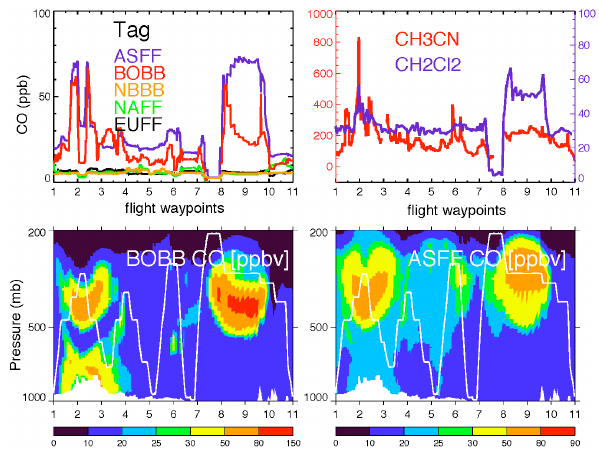
Fig. 6. Top left: the five tagged CO mixing ratios during the ARC- TAS flight 21 on 8 July from Cold Lake, Canada, terminating in with the white line representing the flight track. Thule, Greenland. Top right: the corresponding measured CH 3 CN and CH 2 Cl 2 during the same flight. Bottom left and bottom right are curtain plots for the tagged CO species BOBB and ASFF, re- spectively, with the white line representing the flight track.